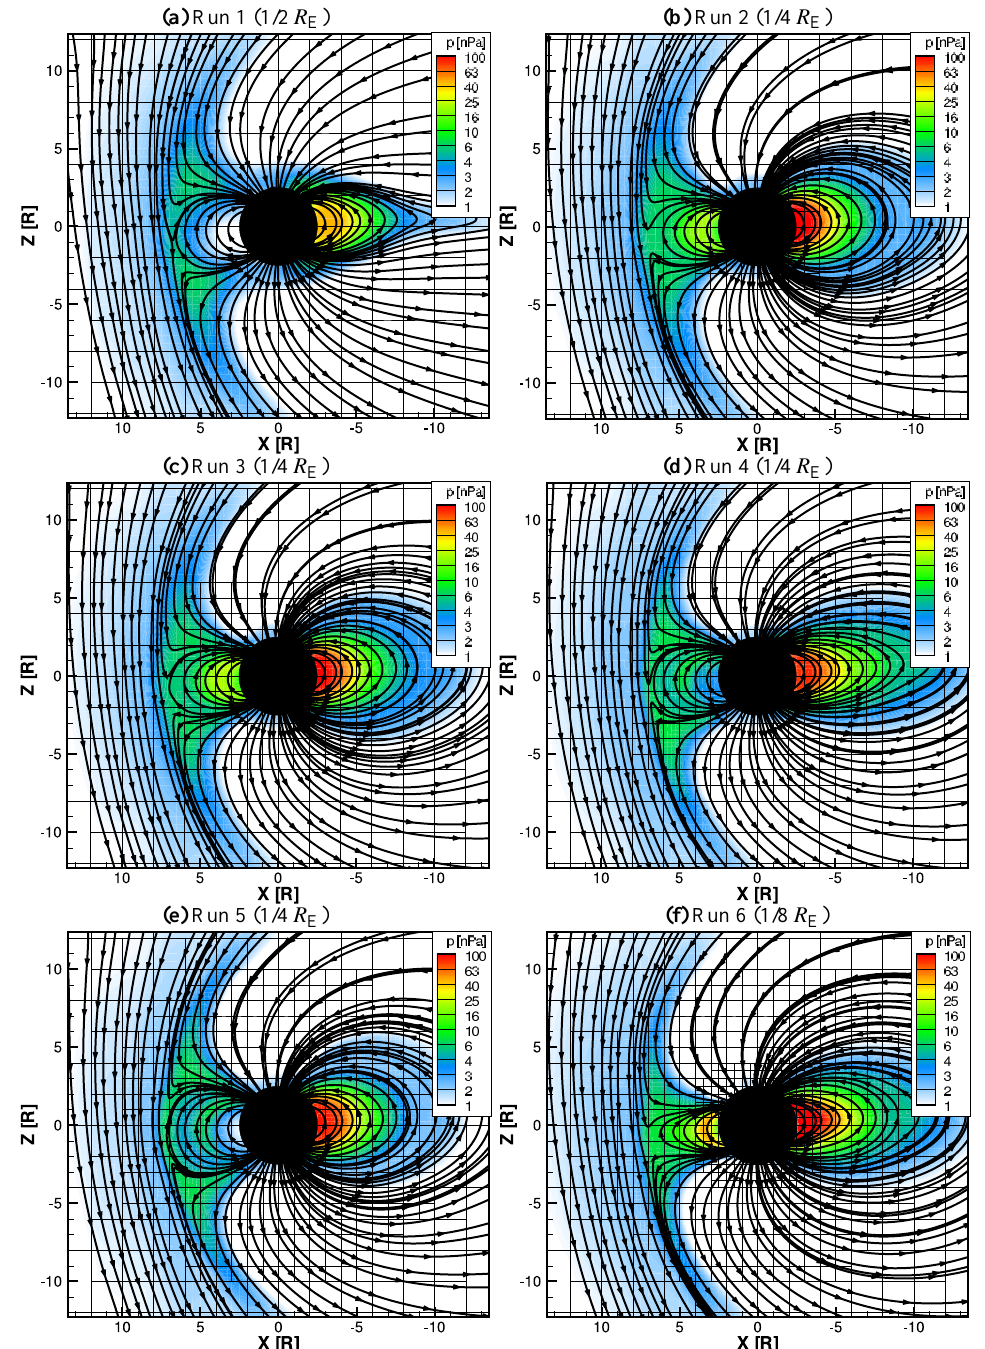
Fig. 13. Plots from Runs 1–6 showing the pressure and magnetic field topology at 04:40UT on 4 May 1998. The grid resolution is indicated by the plots of the block boundaries, as in previous